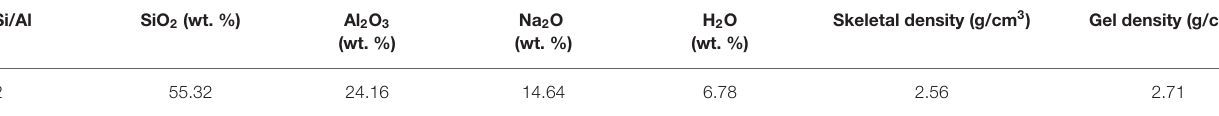
TABLE 1 | Chemical composition of the N-A-S-H model. Si/Al SiO 2 (wt. %)